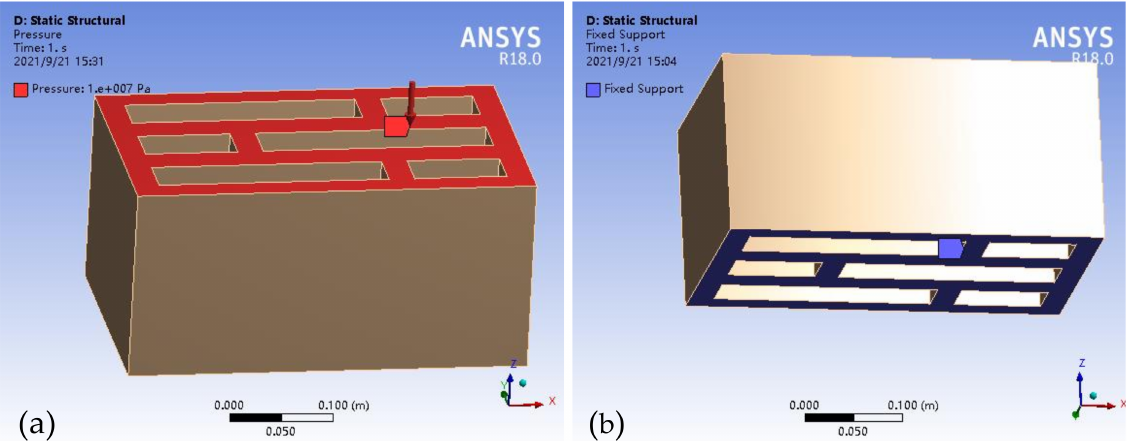
Figure 4. ( a ) Load on the upper surface of the model; ( b ) constraint on the bottom of the